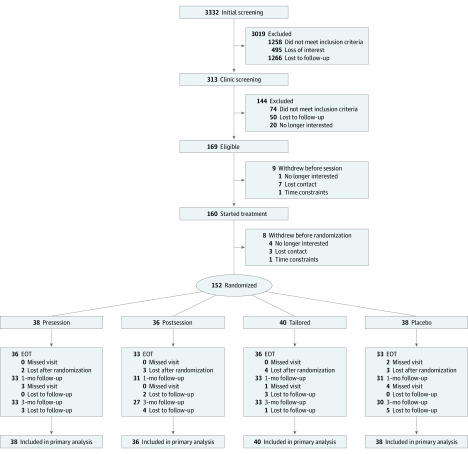
CONSORT Flow DiagramEOT indicates end of treatment (1-week follow-up).